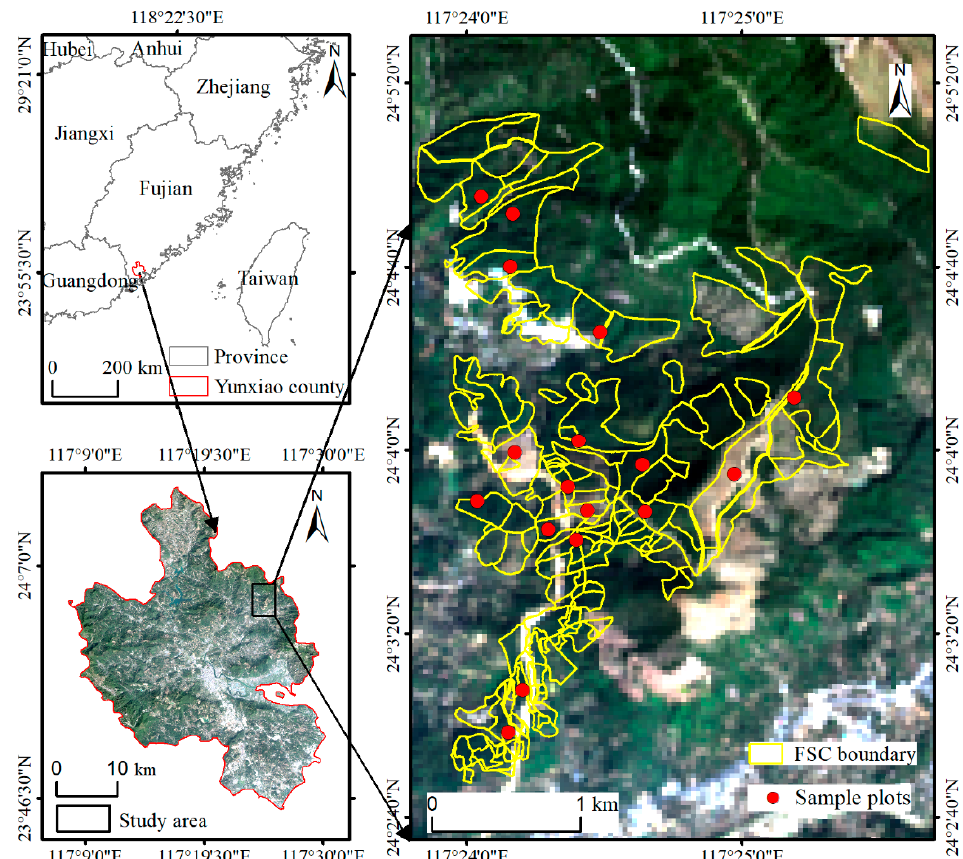
Figure 1. Location of the study area, spatial distribution of sample plots, and forest sub-compartment of eucalyptus. The base map is a true color composite of Sentinel-2 image.